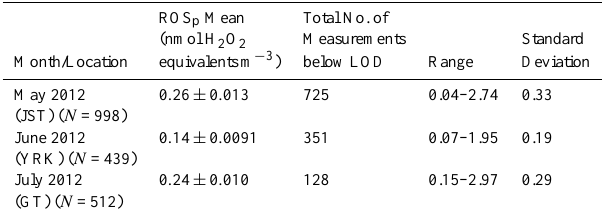
Table 2. Comparison of average and span of online ROS p measure- ments during summer study